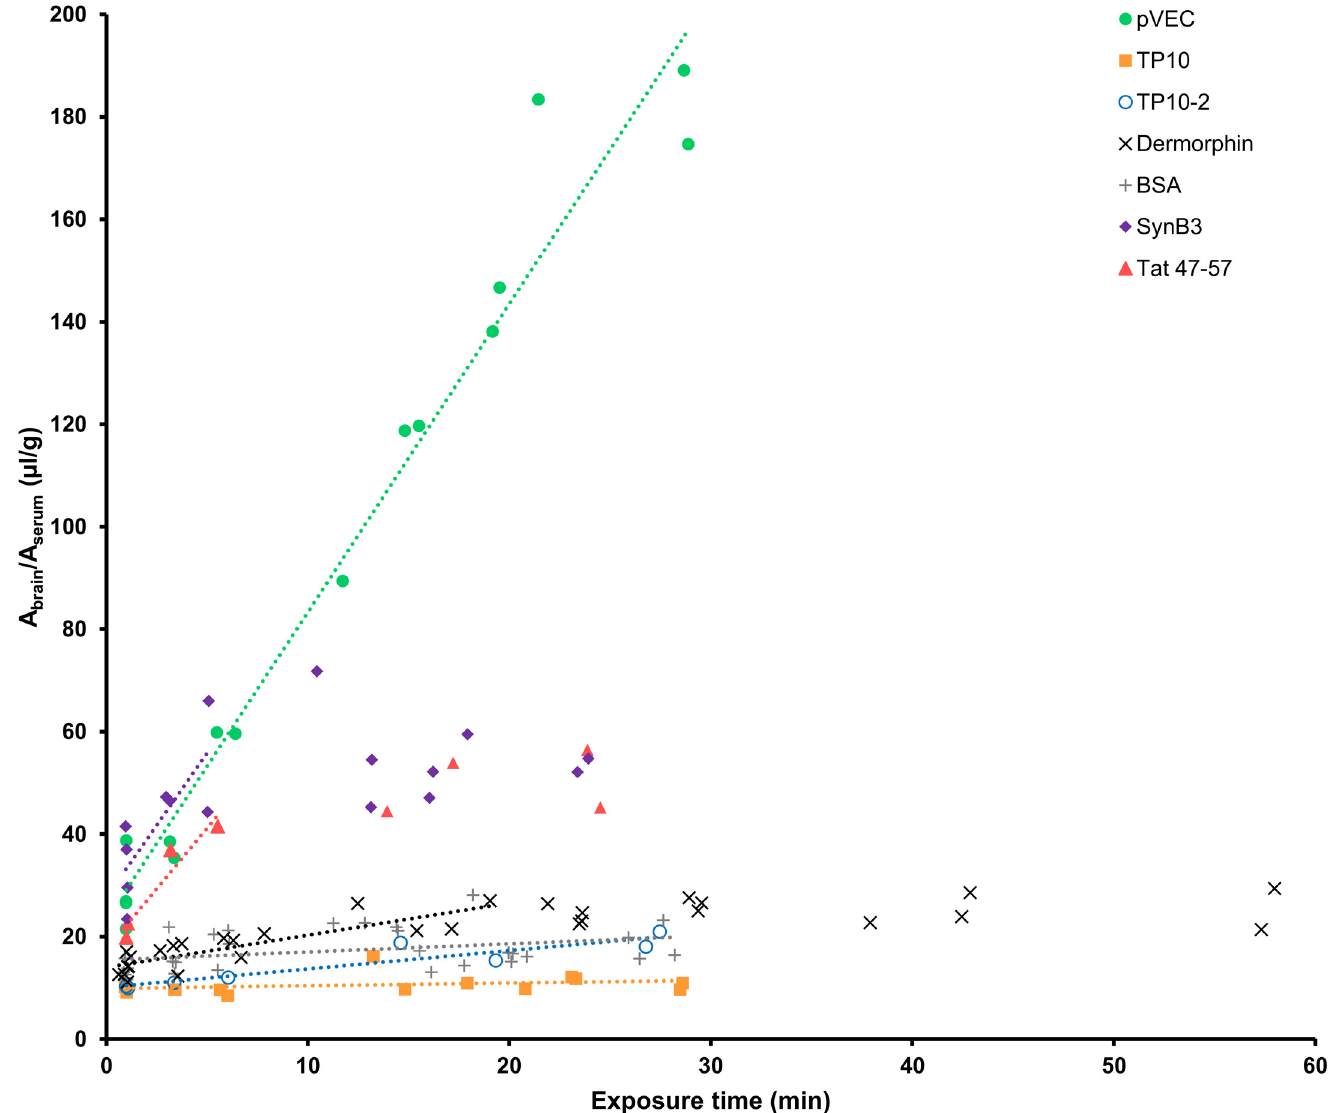
Fig 1. Results of the multiple time regression analysis experiment of the five CPP using the linear model.